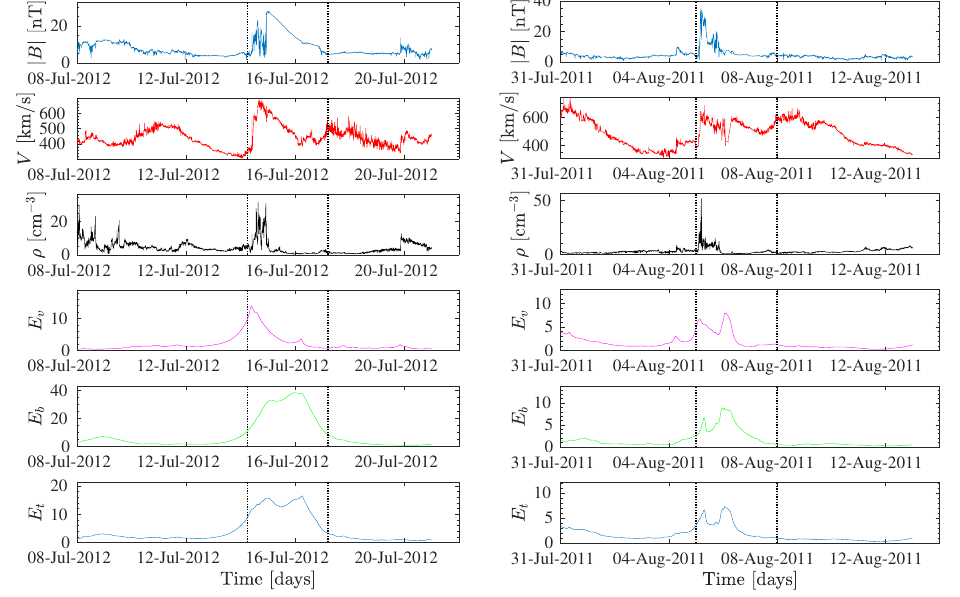
Figure 1. From top to bottom: temporal evolution of the total magnetic field | B | , solar wind bulk velocity V , and the solar wind density ρ for two samples measured by Wind spacecraft: left column 15 July 2012 06:00:00 → 17 July 2012 05:00:00 Dst = − 139, right column 6 August 2011 22:00:00 → 7 August 2011 22:00:00 Dst = − 115. The vertical dashed lines represent the CME du- ration. In the last three panels, the temporal evolution of the integrated quantities E v , E b , and E t = E v + E b is